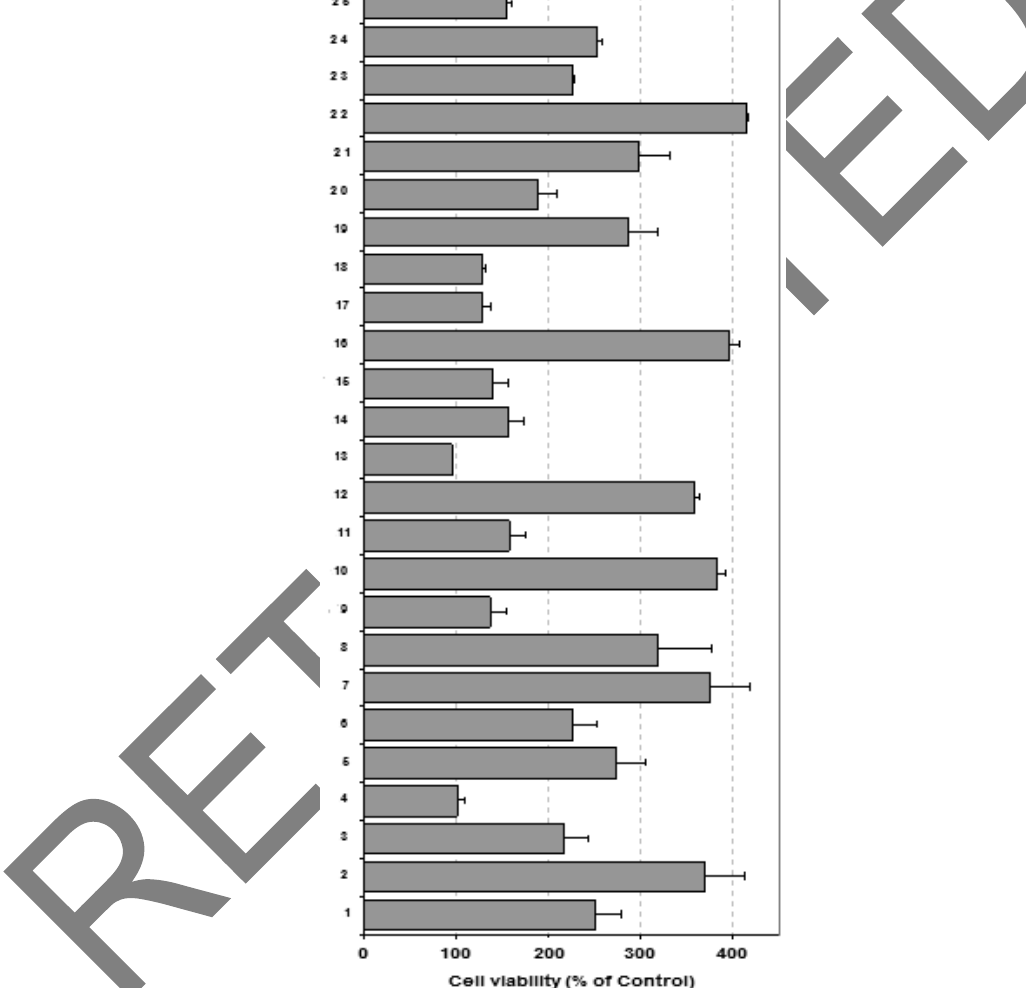
Macrophage viability was compared with the induced proliferation by 1,000 units/mL M-CSF (178% of control). The results are represented as the percentage of control untreated cells (Mean ± SD, n =